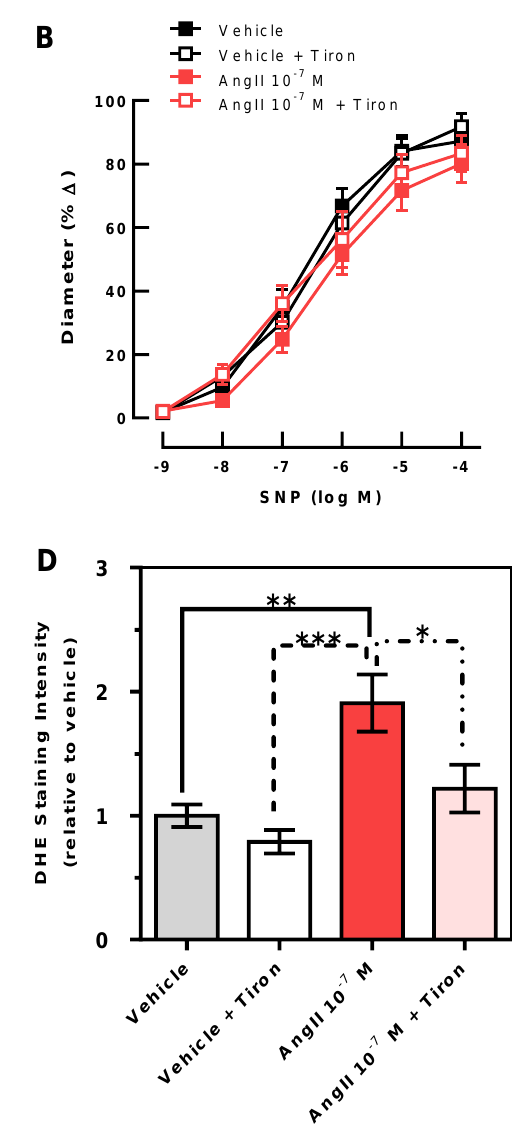
Figure 3. While Ang II 10 − 7 M reduced endothelium-dependent vasodilation (reduced acetylcholine responses), the ROS scavenger Tiron 10 − 3 M retained acetylcholine-induced vascular responses in Ang II 10 − 7 M-incubated ophthalmic arteries ( A ). Ang II and Tiron had no effect on the SNP response (endothelium-independent vasodilation) ( B ). Data are expressed as mean ± SE ( n = 8 per group; ** p < 0.01, Ang II 10 − 7 M versus vehicle + Tiron; + p < 0.01, Ang II 10 − 7 M vs. Ang II 10 − 7 M + Tiron; * p < 0.05, Ang II 10 − 7 M versus vehicle). Ang II 10 − 7 M increased fluorescent intensity to DHE in ophthalmic artery cross-sections, indicative of elevated ROS levels, whereas Tiron prevented an Ang II-induced increase in DHE staining intensity ( C , D ). Data are expressed as mean ± SE ( n = 8 per group; *** p < 0.001; ** p < 0.01; * p < 0.05). Scale bar = 50 µm.